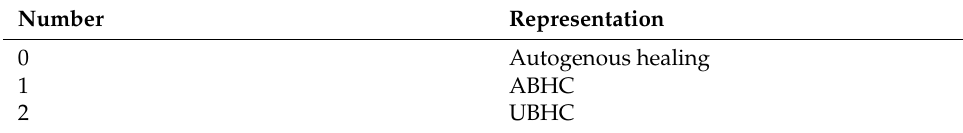
Table A4. Types of BSHC.